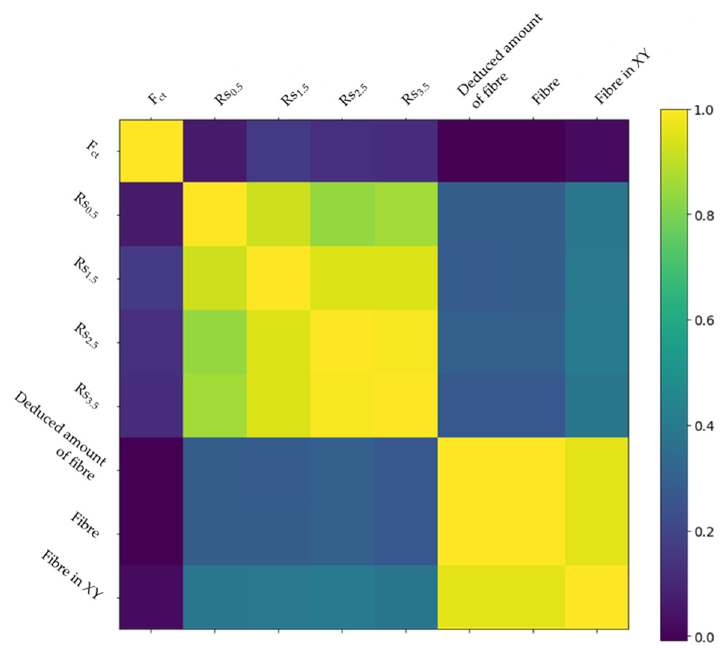
Figure 15. Correlation plot.